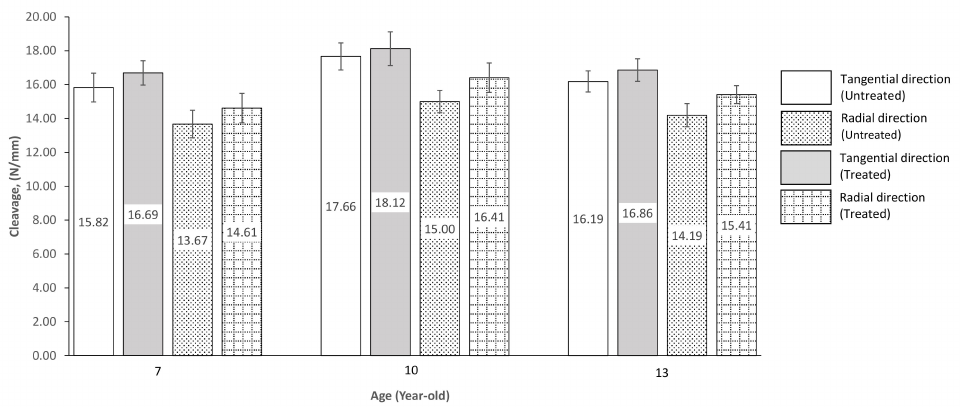
Figure 9. Cleavage strength values of Acacia hybrid sample compared within the age groups, grain direction, and treatment condition at the air-dry